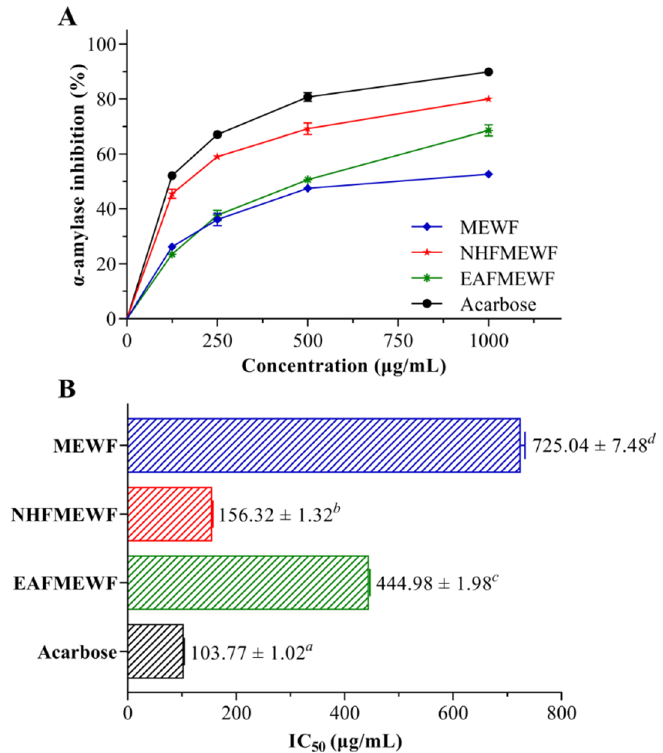
Figure 3. Anti- α -amylase activities of methanol leaves extract of W. fruticosa and its different fractions compared with the reference inhibitor acarbose. Values are shown as mean ± SEM ( n = 3). ( A ) The percentage inhibition of α -amylase activity at four different concentrations ( µ g/mL). ( B ) IC 50 values ( µ g/mL) for α -amylase activity. Values marked with different superscript letters ( a , b , c , d ) in different columns signify statistical differences at p < 0.01 (Tukey’s HSD test). MEWF, methanol extract of W. fruticosa leaves; NHFMEWF, n-hexane fraction of methanol extract of W. fruticosa leaves; EAFMEWF, ethyl acetate fraction of methanol extract of W. fruticosa leaves.